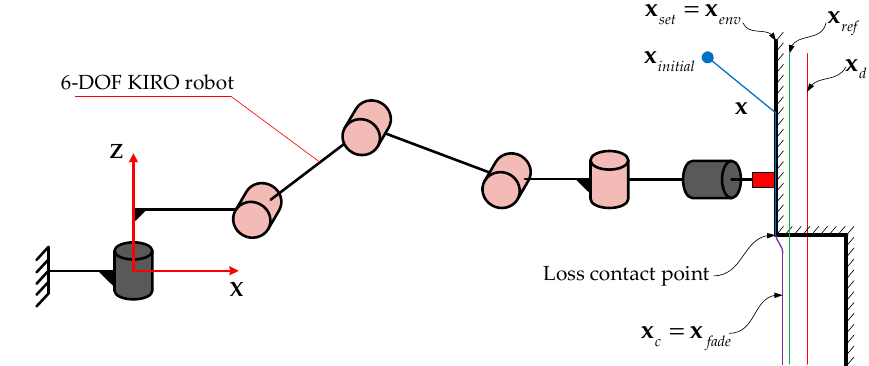
Figure 5. Working scenario of the 6-DOF KIRO robot and prescribed expected trajectory after contact-loss happens.